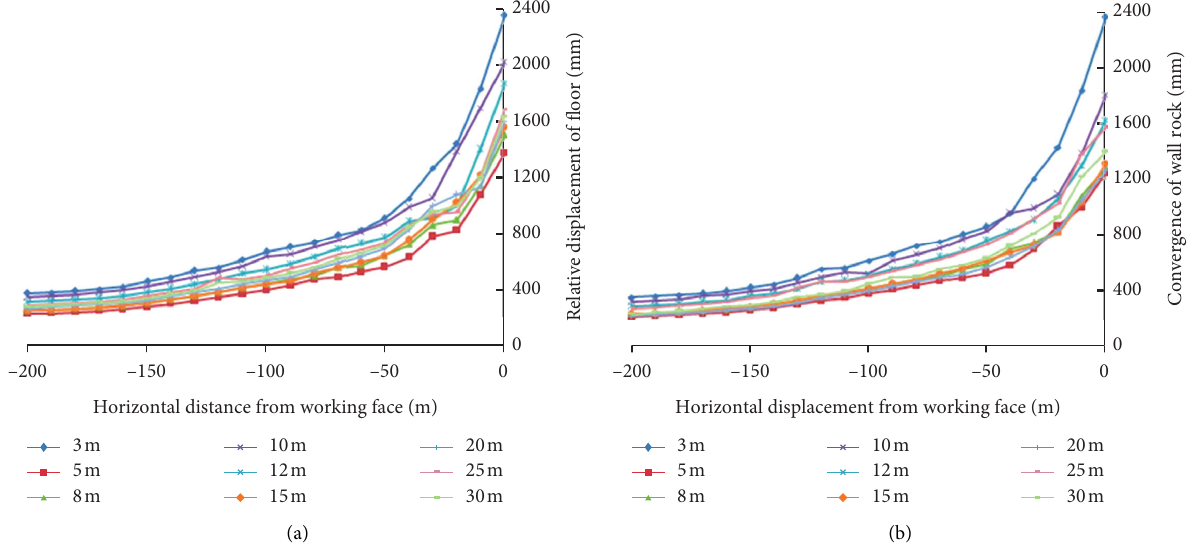
Figure 15: Relative displacement curve of roadway roof and floor at different pillar widths. (a) Vertical displacement curve. (b) Horizontal displacement curve of two sides.